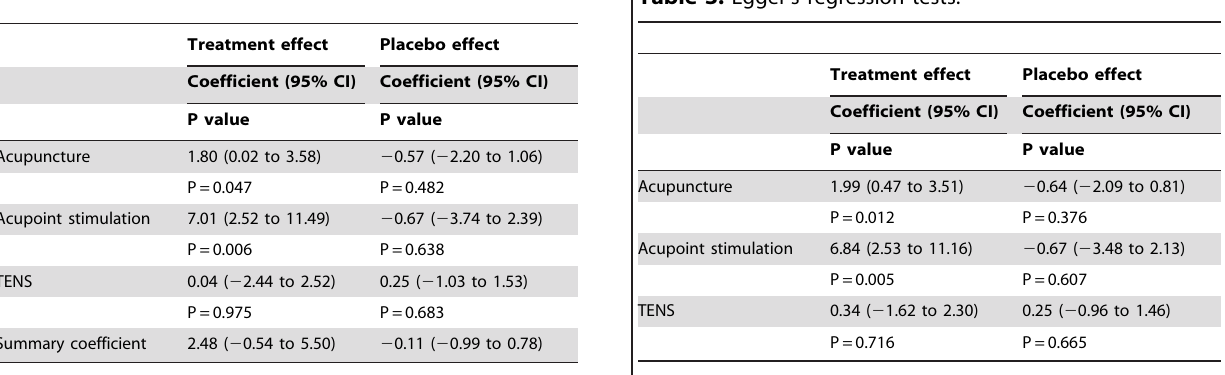
the placebo effect (Figure 4A and B), the effect sizes combined over eligible trials were smaller than those simulated on data from non- parametric trim and fill analysis, although they were included within the range of the 95% confidence interval for hypothetical placebo effect from meta-regression with standard error = 0. Table 3. Egger’s regression